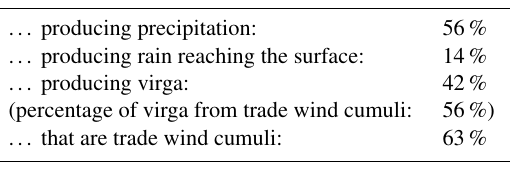
Table 3. Precipitation and virga statistics. Precipitation-producing clouds are defined as clouds that either produce virga or rain that reaches the ground. Clouds with their base below 4km make up about 73% of the data set. Clouds with ceilometer-detected cloud base below 1km are classified as trade wind cumuli and considered individually. These clouds make up about 46% of the entire data set. Clouds with cloud base below 4km ...